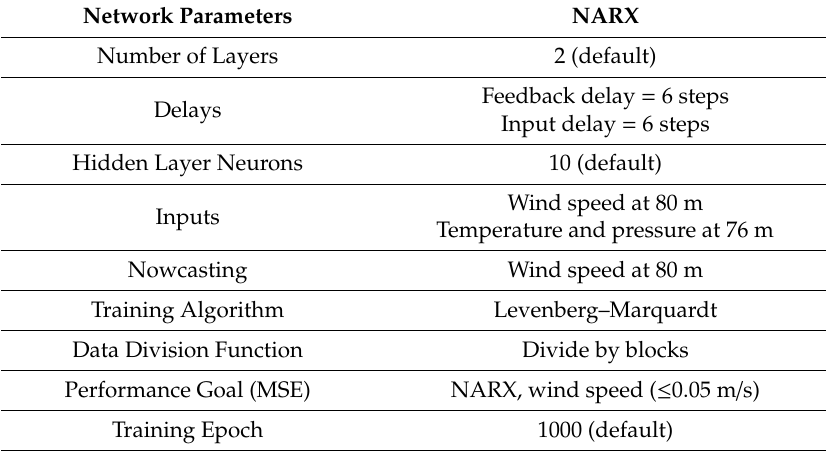
Table 1. Single-network NARX parameter